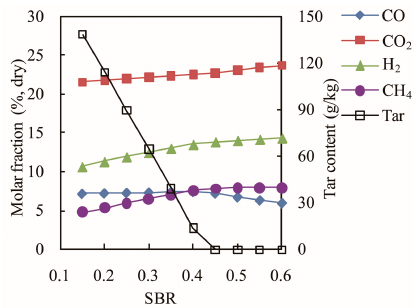
Figure 15. Effects of SBR on syngas composition and tar content at T = 950 K and ER = 0.3.